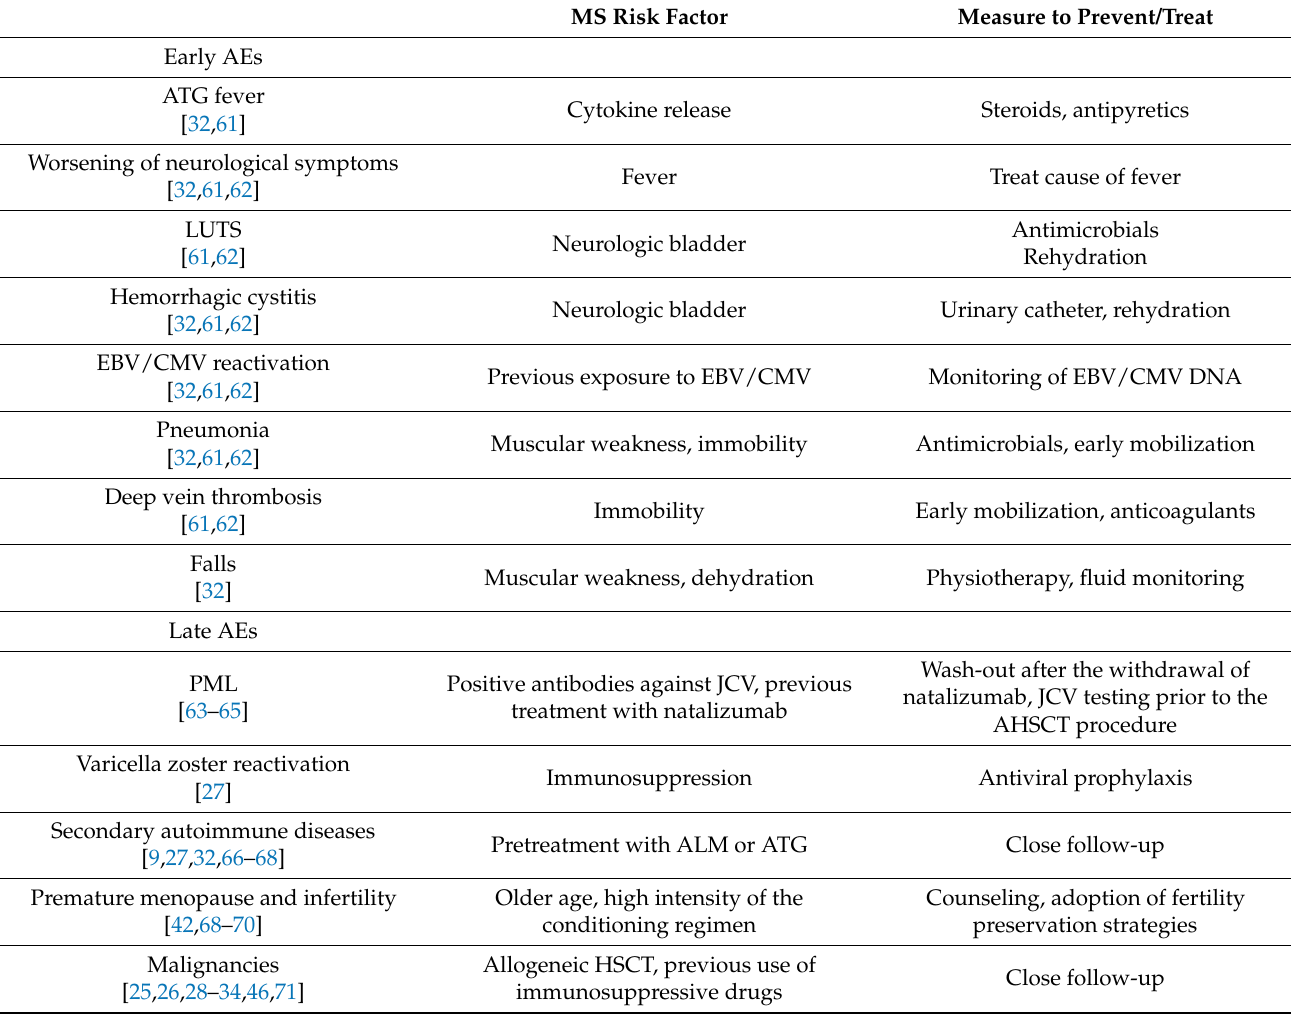
Table 3. AHSCT-related complications commonly associated with MS